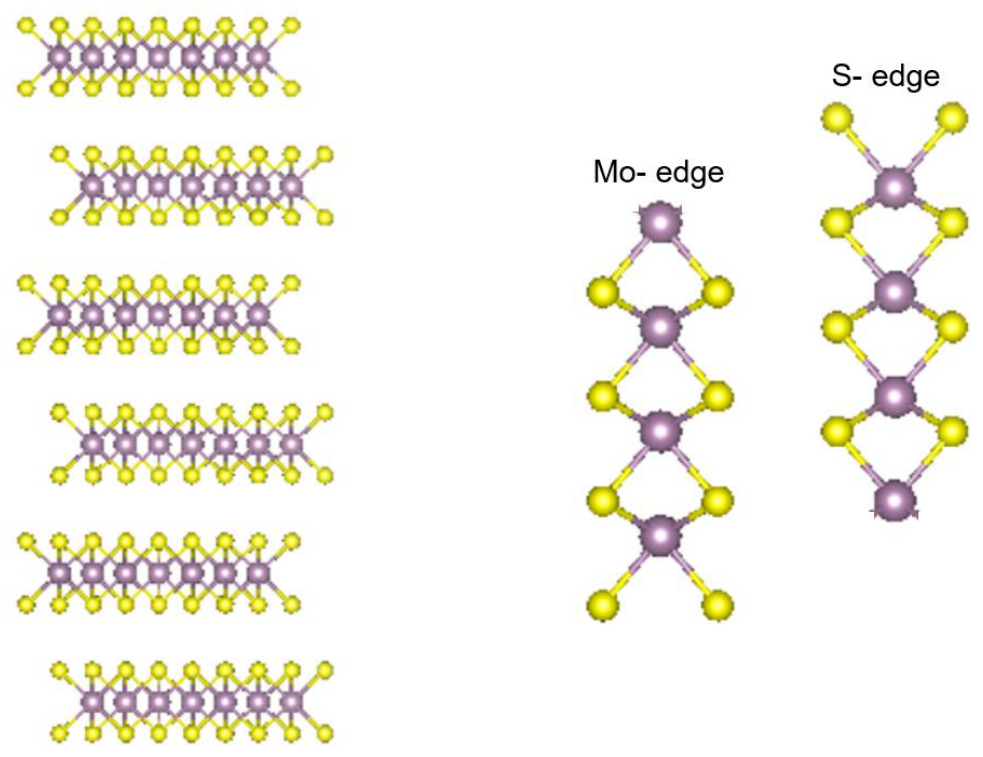
Figure 1. Structure of layered TMS dichalcogenides (based on the molybdenite structure), the metal- rich edge sites, and the sulfur-rich edge sites. The rim and edge model for the activity indicates that the basal plane of the TMS is non-active or has very low activity [76 – 79]. From hydrogenation of C – S bonds in the HDS reactions, it has been shown that stacks of 4 – 5 layers of MoS 2 planes show activity. How- ever, the basal plane is inactive towards the reaction where the reactivity occurs at the edge or rim of the MoS 2 stack. At the rim sites the active hydrogenation of the C – S bonds occurs, whereas on the edge site the C – S-bond breaking occurs [76 – 79]. This edge – rim activity observed in HDS reactions is preserved in electrocatalytic reduction reactions of CO 2 where the basal plane is inactive and the reactivity is observed only on the rim/edge of the stacked planes. Figure 2 shows the different sites for in the MoS 2 rim and edge models and the respective reactions.